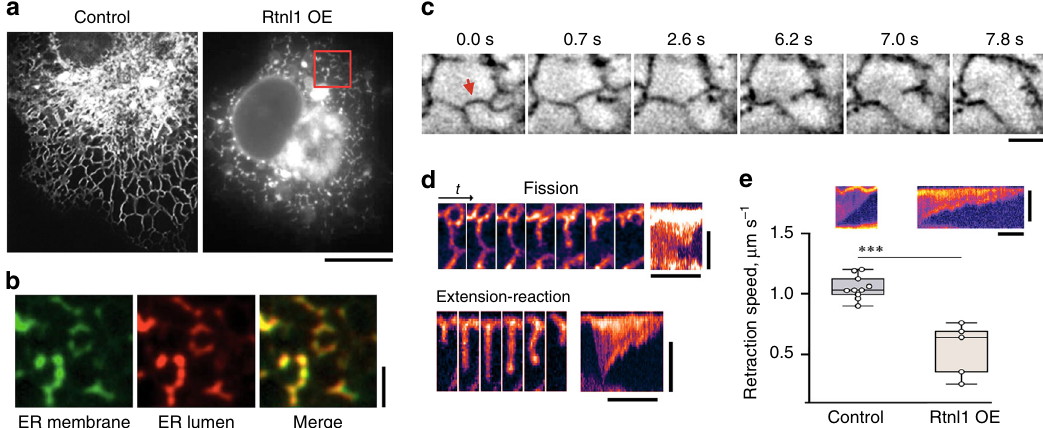
Fig. 3 Altered dynamics and fi ssion of ER branches during Rtnl1-driven fragmentation of tubular ER network. a Retraction and constriction of the ER network (labeled by mCHERRY-KDEL) in COS-7 cells expressing Rtnl1. Global ER constriction results in the appearance of multiple bright punctae of mCHERRY- KDEL fl uorescence. Scale bar 10 μ m. b Blow-ups of the ER in COS-7 cells co-transfected with Rtnl1-myc (identi fi ed by the simultaneous expression of nuclear CFP), mCHERRY-KDEL and GFP-Rtnl1 (24 h PT). Both fl uorescence markers localize to visibly disconnected punctae. Scale bar 2 μ m. c Image sequence showing scission (red arrow) of an ER branch in a Rtnl1-expressing COS-7 cell. Scale bar 2 μ m. d Image sequences showing the scission (upper sequence, corresponding to that shown in ( c )) of the ER branch correlated with the ring closure and the transient extension/contraction (lower sequence) of the ER branch. The sequences are followed by corresponding kymographs. The pseudo-color representation highlights the local constriction preceding the scission. Scale bars are 2 μ m and 8 s. e Kymographs showing retraction of ER branches in control ( n = 10 branches) and Rtnl1-expressing ( n = 5 branches) cells. Scale bars are 2 μ m and 2 s. The box-plot shows branch retraction speeds. Statistical signi fi cance: unpaired two-tailed t test, *** p < 0.001. Boxplots show IQR, whiskers indicate minimum and maximum of the dataset. Source data are provided as a Source Data fi